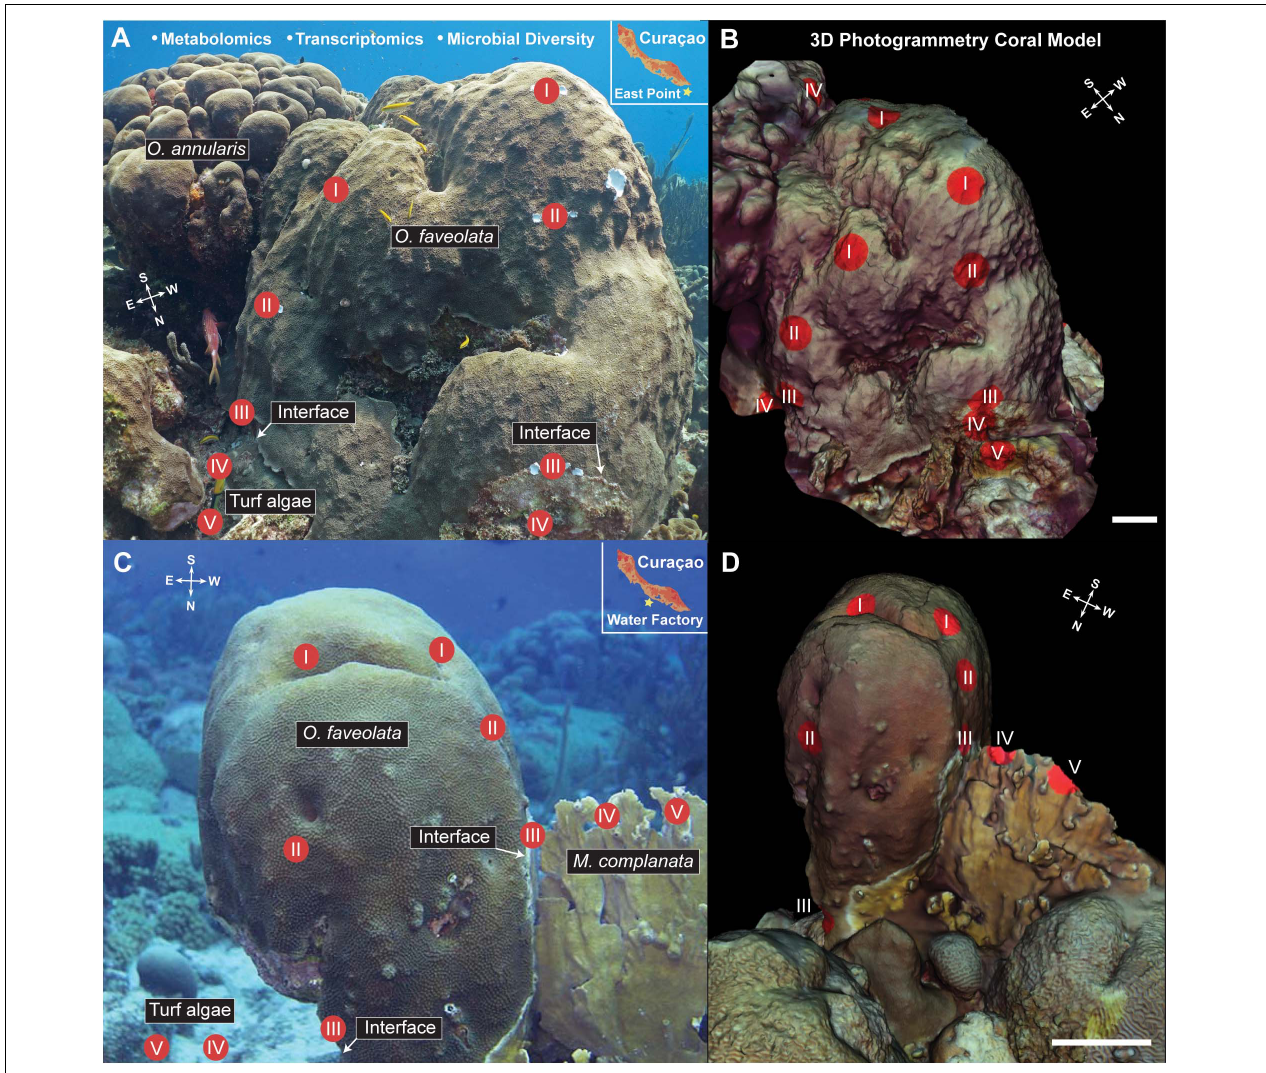
FIGURE 1 | Images (A,C) and 3D models (B,D) of the Orbicella faveolata corals with sampling points overlaid for visualization. Inset in panels (A,C) show the geographic location of the sampling efforts. Compass insets indicate the orientation of the coral colonies for cardinal direction. Three samples were taken from each sampling point (I-V), one for 16S and 18S rDNA amplicon sequencing, one for metatranscriptomic sequencing, and one for LC MS/MS metabolomic analysis for a total of 60 samples (24 coral, 12 interface, and 24 competitor) taken at each site (Water factory and East Point). Models were created using Autodesk ReCap Photo and 3D molecular mapping was performed using ili (scale bar = 20 cm). White arrows indicate the interface between O. faveolata and the interacting competitors (turf algae, Orbicella annularis , Millepora complanata ).